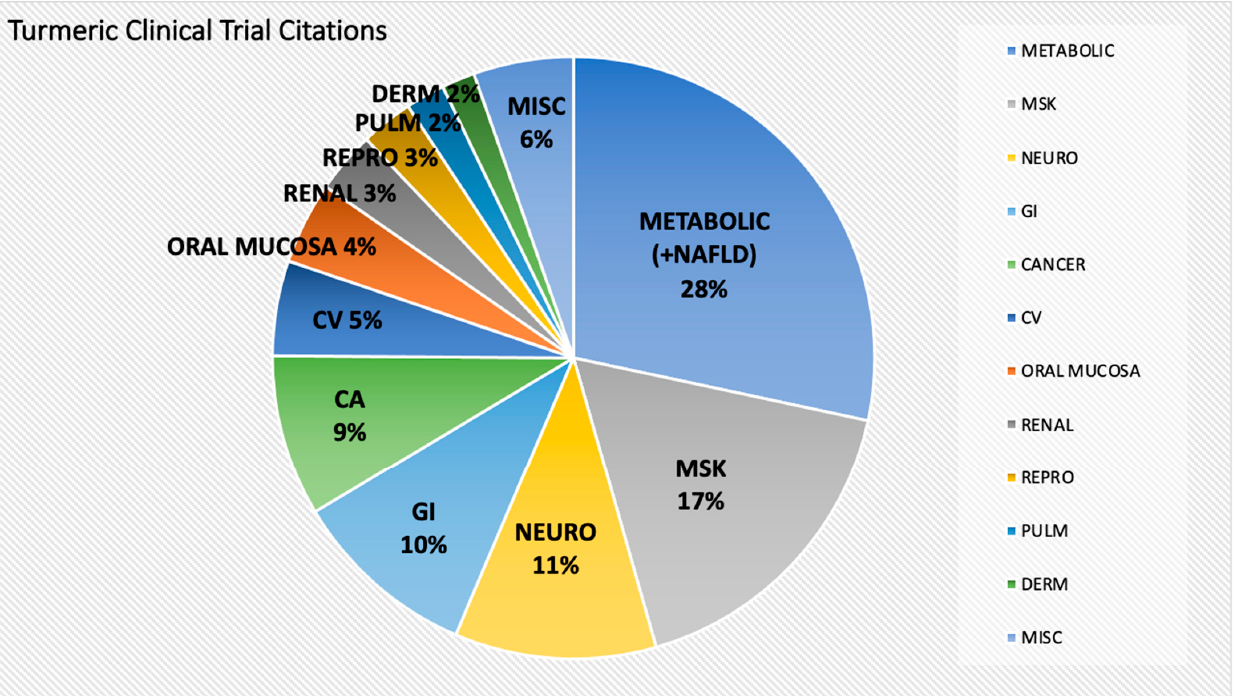
Figure 3. Turmeric clinical trials by organ system or disease process. Clinical trials were organized for analysis by organ system (e.g., musculoskeletal [MSK], neuropsychiatric [NEURO], gastrointestinal [GI], cardiovascular [CV], oral mucosa, renal, reproductive organs [REPRO], pulmonary [PULM], or dermatologic [DERM] disorders) or disease process (metabolic disorders including non-alcoholic fatty liver disease [METABOLIC + NAFLD] or cancer [CA]).